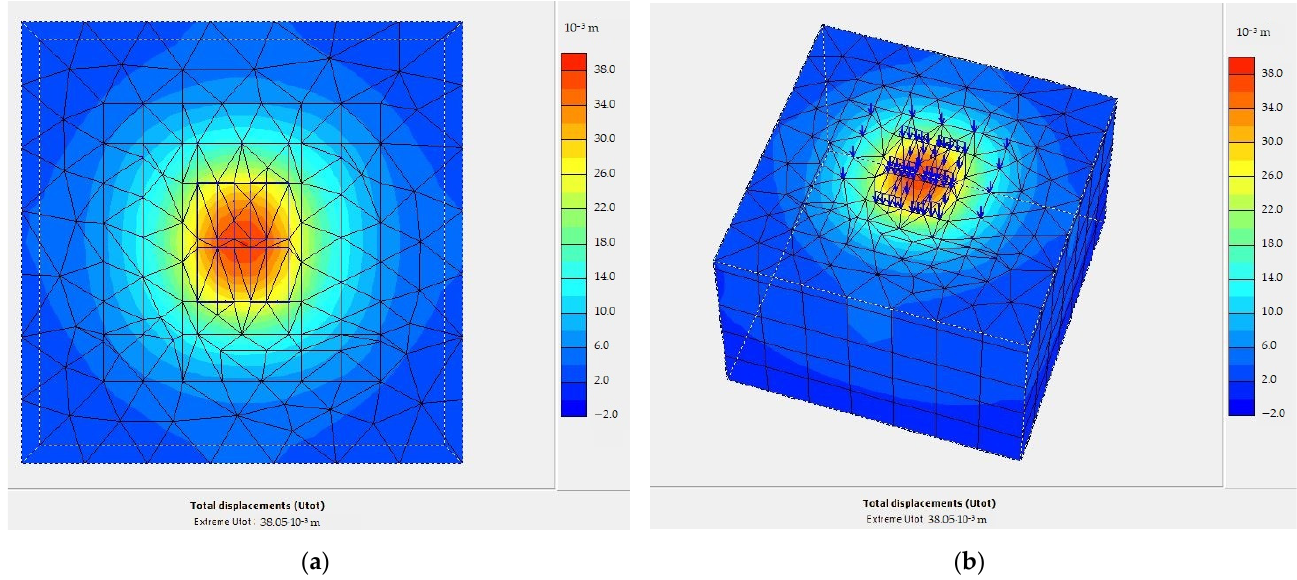
Figure 15. Settlement in vertical Z-direction: ( a ) view of the surface of the raft; ( b ) volumetric model. Horizontal displacement at the surface level of the raft in block R ranges from 1 mm to − 1 mm in the X-direction (Figure 16). The sign of displacement alternates from tension to compression and corresponds to 1 mm deformation per 36 m, which is half of the building width. Thus, according to the results of Plaxis 3D modeling, the largest difference in the vertical displacement was 24 mm, and in the horizontal plane 1 mm within a distance from the center of the core up to 30 m. When determining the relative deformation in the horizontal plane, such a displacement is negligibly small and is less than 1 µε . The distribution of deformations in the X- and Y-direction is presented gradually with smooth transitions and does not display point loads from